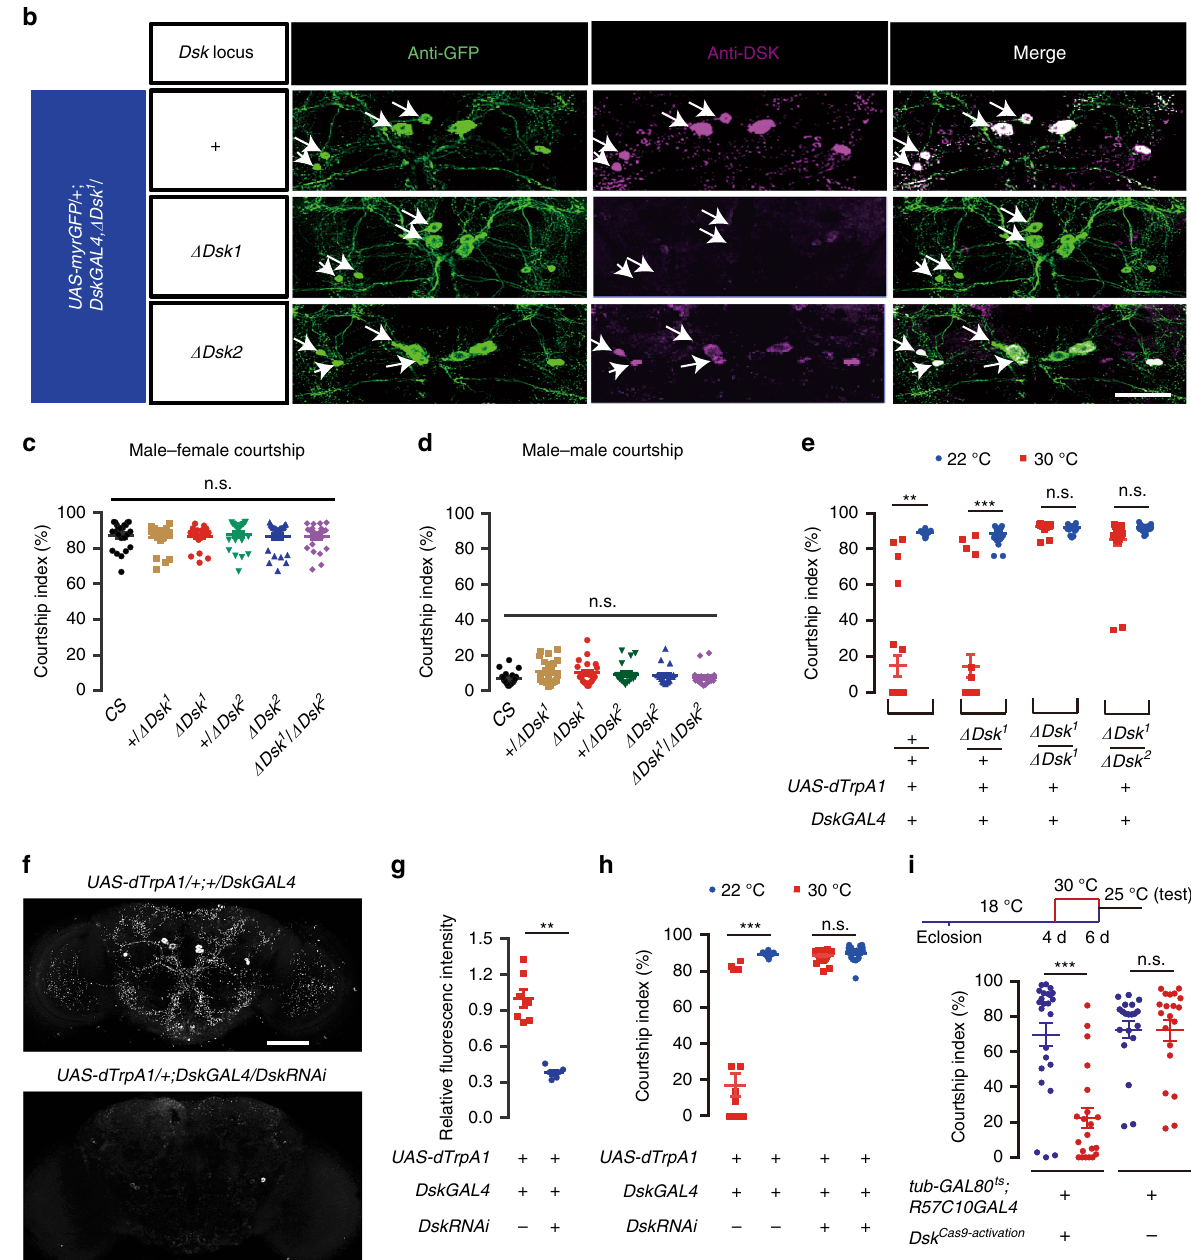
group-housing enhanced synaptic transmission from P1 neurons to Dsk neurons according to the activity-dependent GRASP sig- nals (see Fig. 5i), we asked whether group-housing may affect male courtship in a DSK-dependent manner. We fi rst tested male – female courtship by single-housed males or group-housed